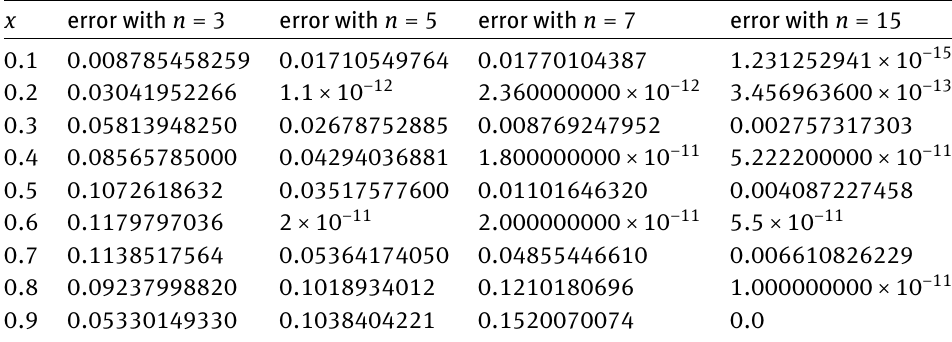
Table 2: Comparison of the error for the proposed method with different n for Example 1.